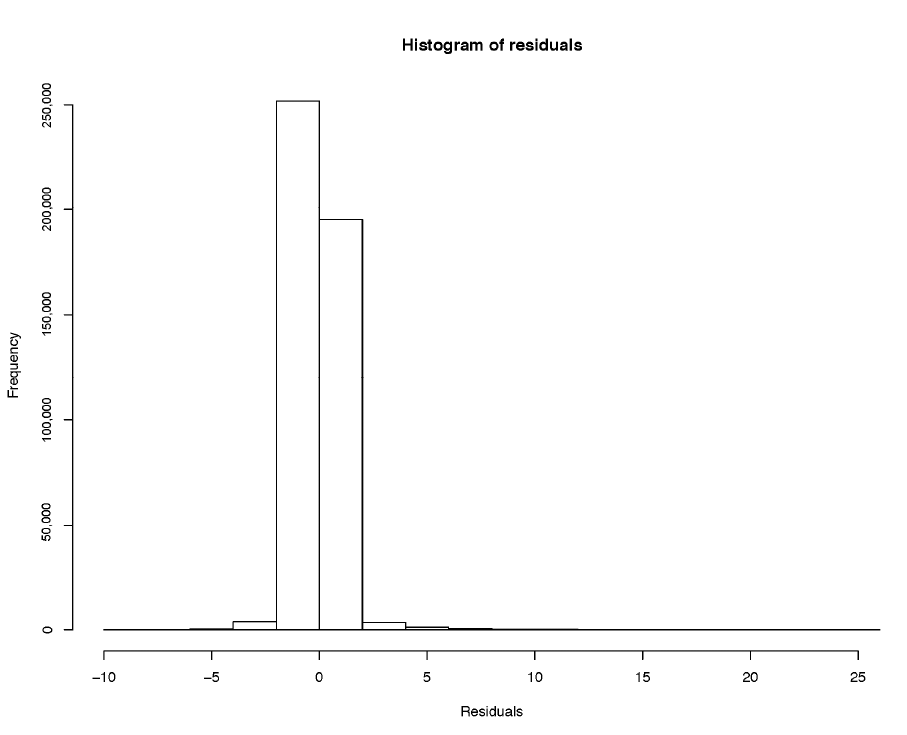
Figure A8. GAM Model Diagnostics